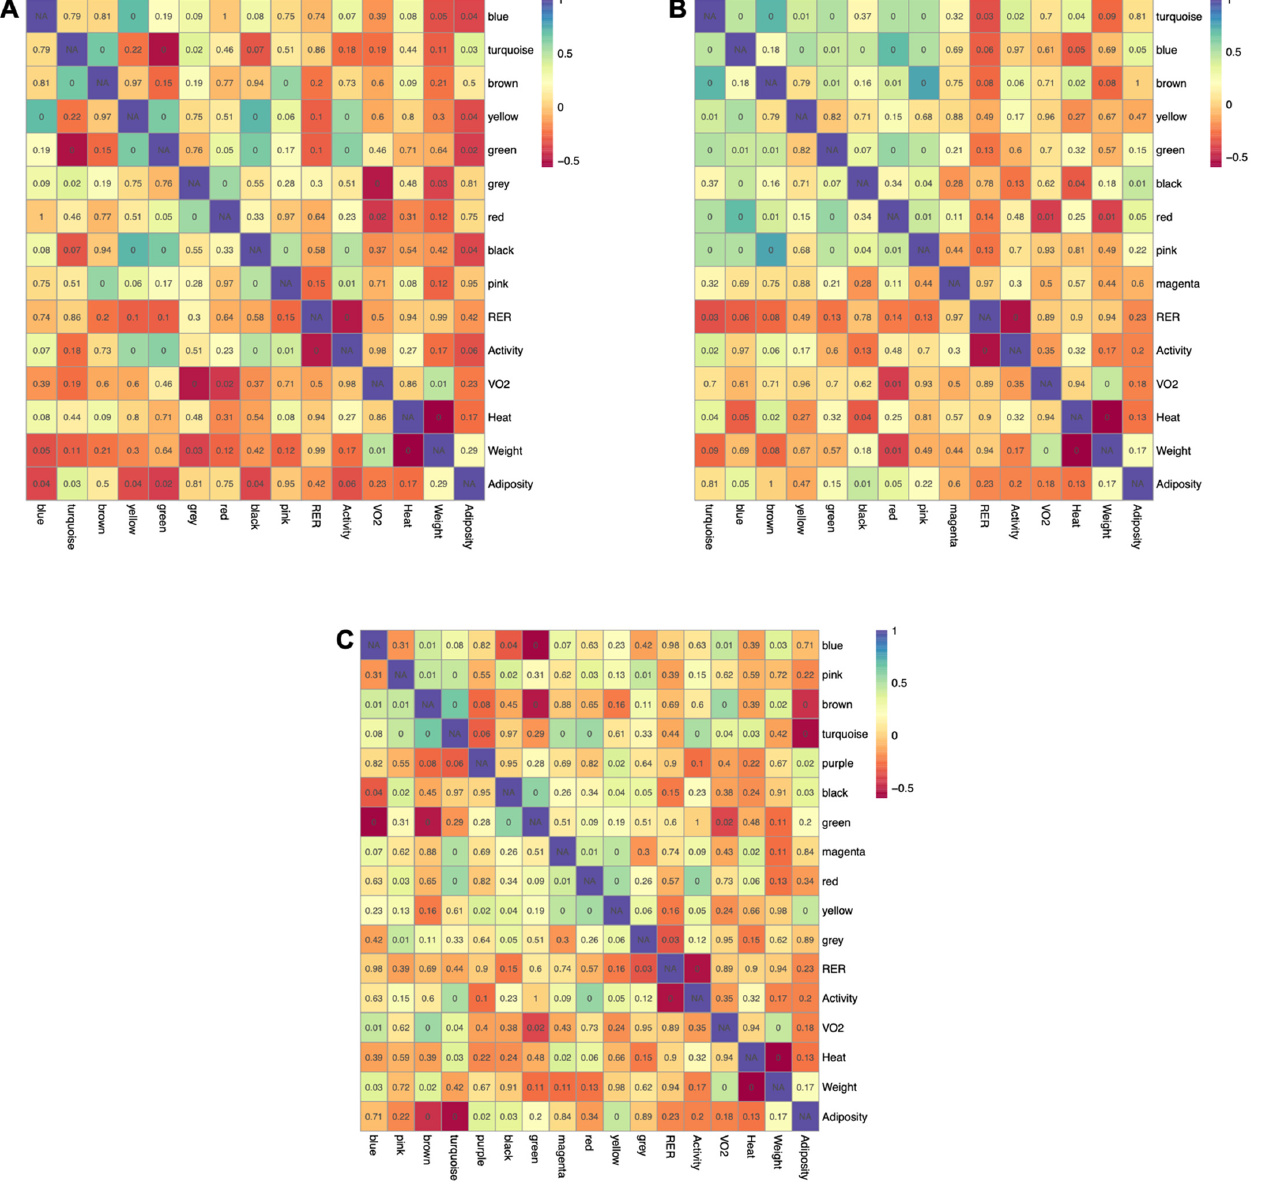
Figure 6. Relationship between modules and physiological measurements for each tissue using Pearson correlation. Correlation heatmaps for adipose ( A ), muscle ( B ), and liver ( C ) depict positive and negative relationships, with the p -value of each relationship overlayed onto the heatmap and corrected using the Benjamini–Hochberg procedure.